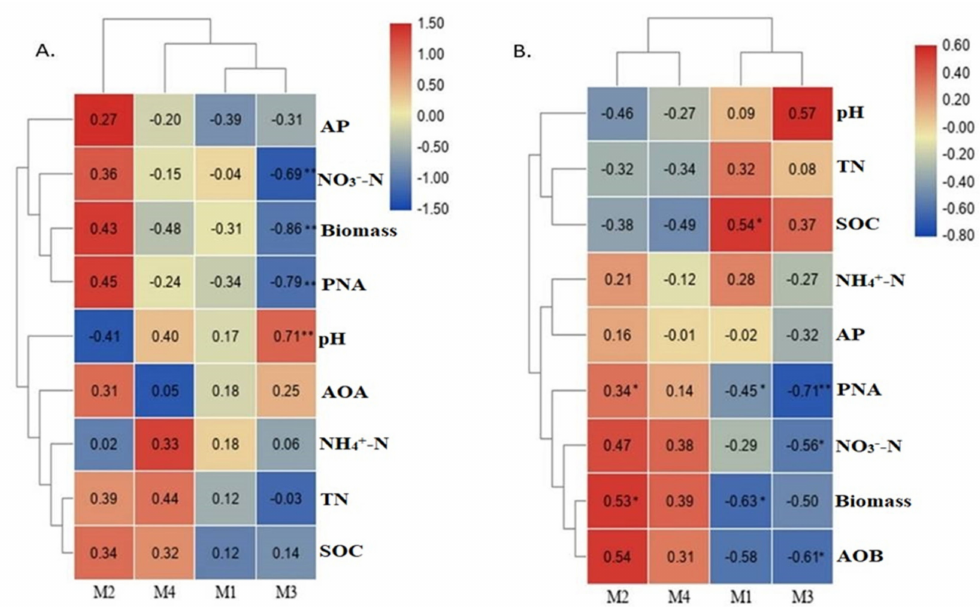
Figure 7. Modules association to soil physiochemical properties, PNA, and biomass; ( A ) AOA and ( B ) AOB abundance. Red color signifies positive correlation, while blue also represents negative correlations. * Stands for p < 0.05 and ** for p < 0.01. It includes the following soil properties: soil pH; SOC = soil organic carbon; total nitrogen (TN); ammonia nitrogen (NH 4+ -N); nitrate-nitrogen (NO 3 − -N); and available phosphorus (AP). Biotic variables also include PNA = Potential nitrification activity and